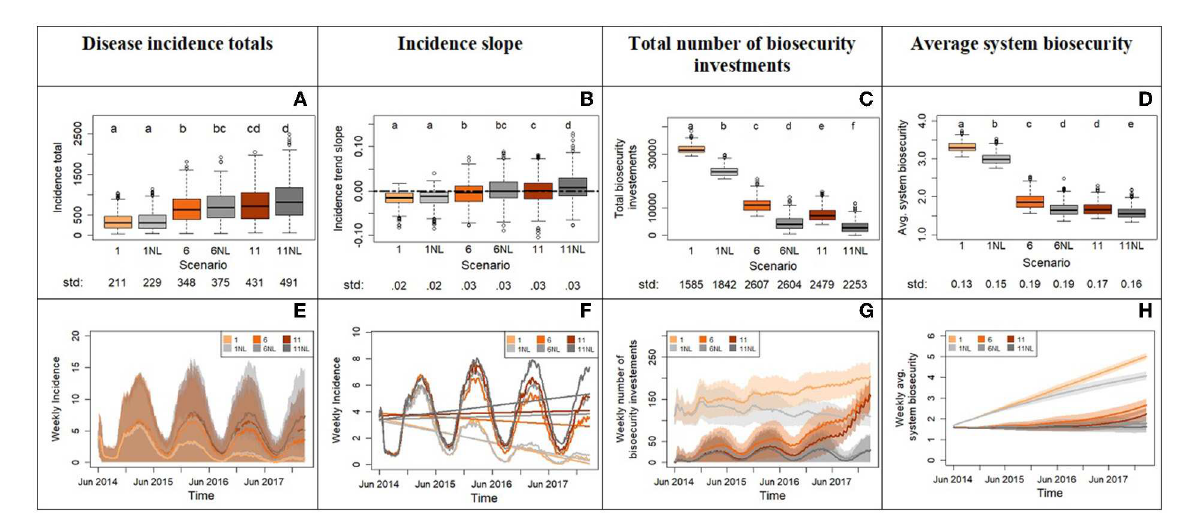
FIGURE7 Outputs from experiment 3 comparing the system with and without risk-attitude learning mechanism for three different scenarios of experiment 2 (1, 6, and 11). The top row displays the box plots of system variables (y axis): disease incidence totals (A) , incidence slope from time series (B) , total number of biosecurity investments (C) , and average system biosecurity (D) . The x axis reports the different scenarios. We applied a Bonferroni adjustment and test each hypothesis at level alpha = 0.0083. Letters on top of the box plots report results from pairwise distribution comparisons across scenarios. Distribution not sharing any letter are different by the two-sample Kolmogorov-Smirnov test at the alpha level of significance. The standard deviation value of each distribution is printed below the box-plot x axis. The bottom row of the figure (E–H) displays the time series with weekly frequency for the variables. The colored shades show the variability provided by the Monte Carlo replicates. Panel (F) zooms into the average weekly incidence lines of panel (E) and includes the linear